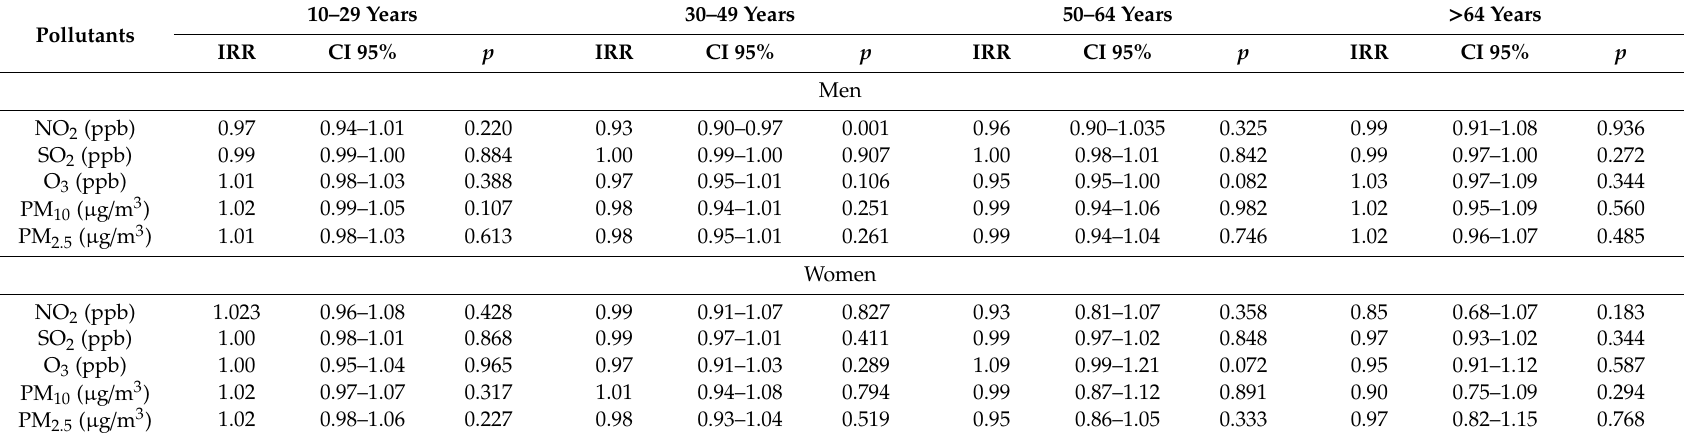
Table 3. Poisson multivariable regression conditional models for daily suicides among men and women by age group in Mexico City, 2000 to 2016.